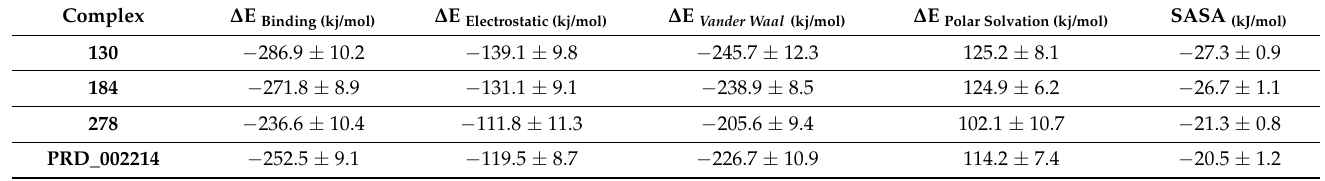
Table 6. Interaction energies and the binding free energy for the four